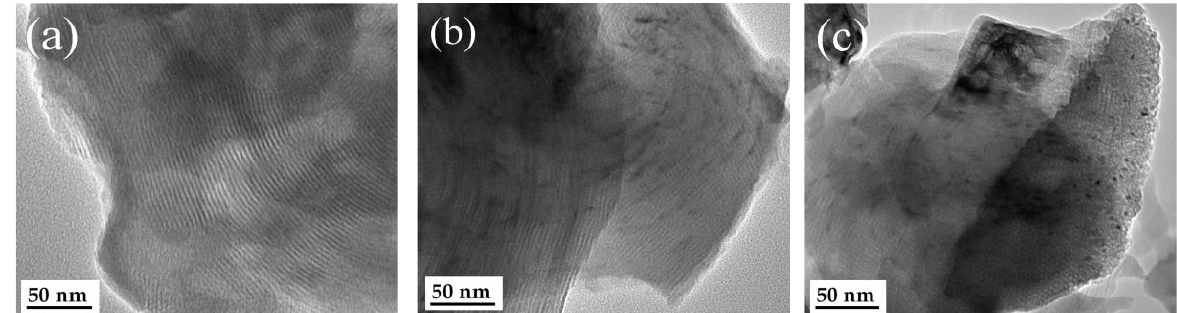
Figure 7. TEM images of MCM-41 support and calcined x Ni/MCM-41 catalysts. ( a ) MCM-41 sup- port, ( b ) 4Ni/MCM-41 catalyst, ( c ) 20Ni/MCM-41 catalyst.